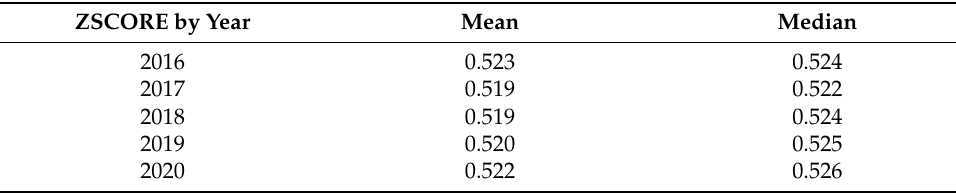
Table 7. Descriptive statistic bankruptcy risk of firm (ZSCORE) by year. Table 8. Regression results of effects of bankruptcy to time of publication annual reports in research